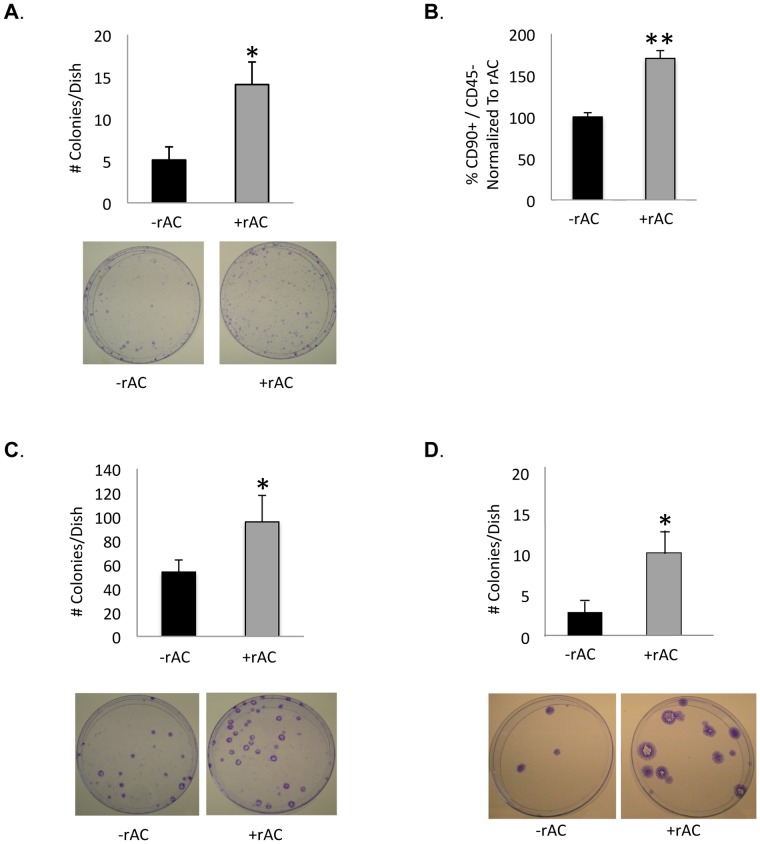
Rat bone marrow cells were isolated and grown for 1 week with or without rAC in standard culture media.rAC was added to the culture media once at the initial plating (5×10E6 cells/cm2). The number of mesenchymal stem cells (MSCs) in the cultures at 1 week was determined by two assays: A) the number of fibroblast-like colony forming units (CFU-F), and B) by flow cytometry (CD90+/CD45-). Note that an ∼2–3 fold increase in the number of rat MSCs was observed using rAC. The same result could be reproduced with C) feline cells (plated at a density of 1–5×106 cells/cm2) and D) equine cells (plated at 3×108 cells/cm2). * = p<0.05, ** = p<0.005. Representative culture plates showing the stained colonies are provided below the quantitative data.